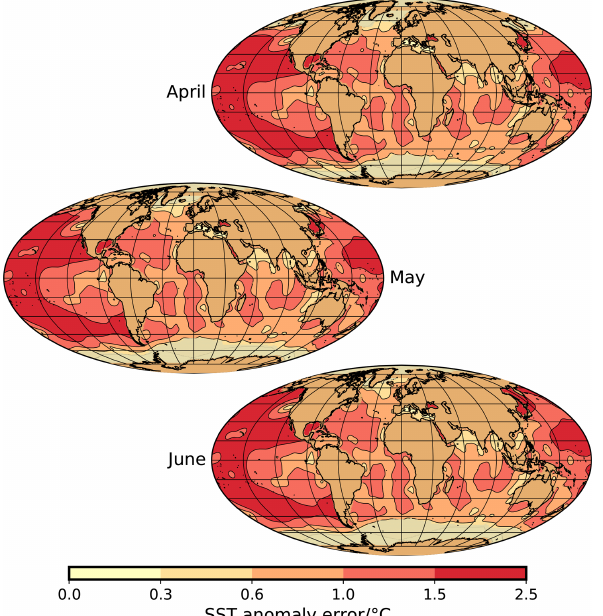
Figure A7. Uncertainty of NSST anomaly (contour map) and sea- ice extent (yellow–brownish areas close to Antarctica and in the Arctic; see Fig. A6) for July, August, and September. For August, we also show the error of the reconstruction at the sediment core locations as estimated by the MARGO Project Members